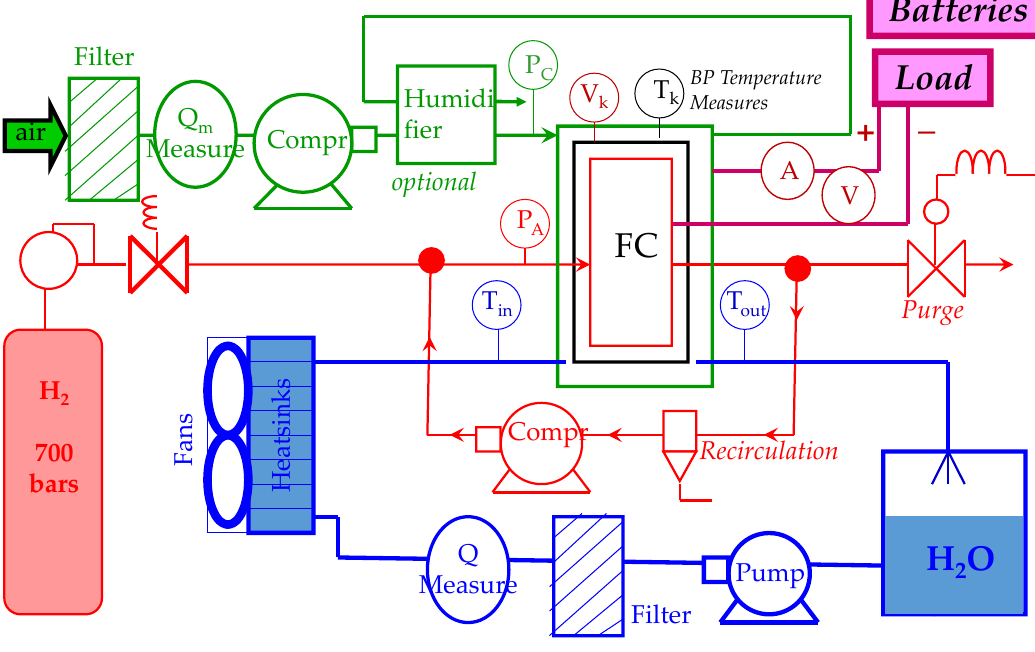
Figure 14. Schematic view of an FCS. green: air line (cathode) | red: hydrogen line (anode) | blue: cooling line | purple: electric line.